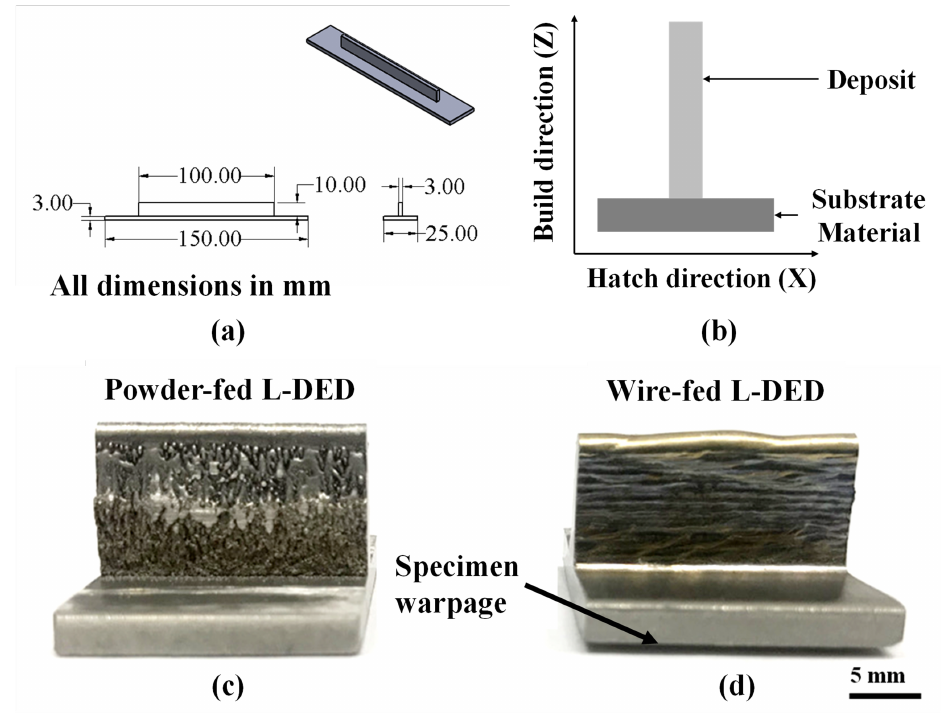
Figure 4. ( a ) Geometry of the thin-wall specimen. ( b ) A schematic showing a representative cross- section for microstructure investigation and microhardness measurements. Images of the physical specimens: ( c ) powder-fed and ( d )